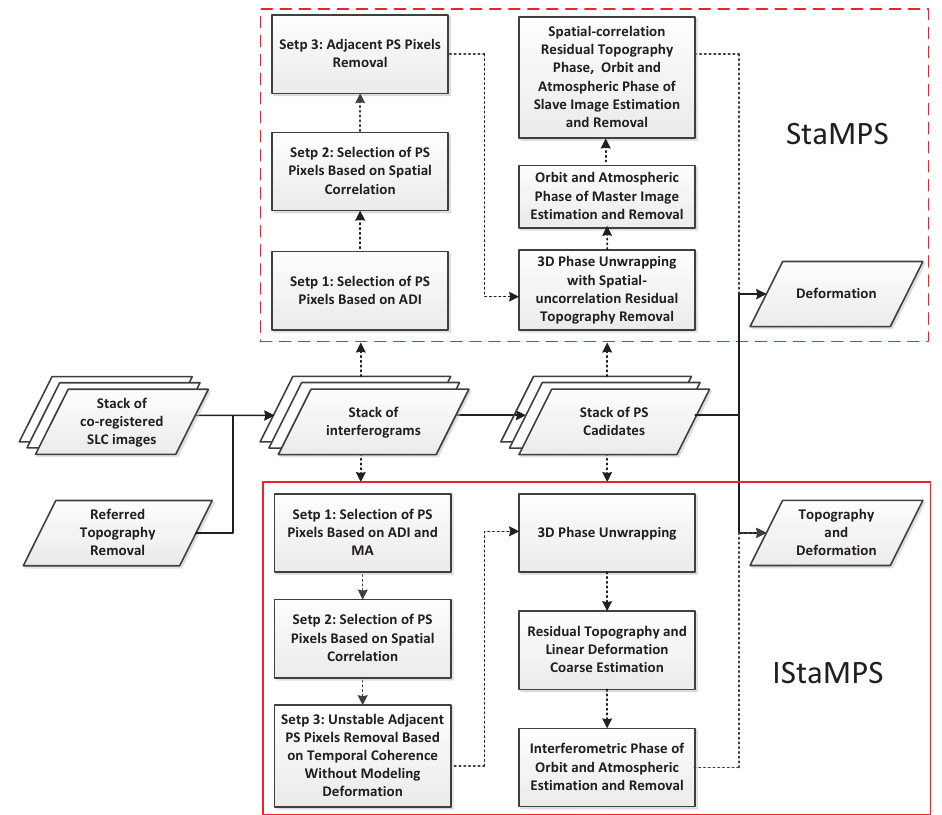
Figure 1. Flow diagram of the implemented method in this